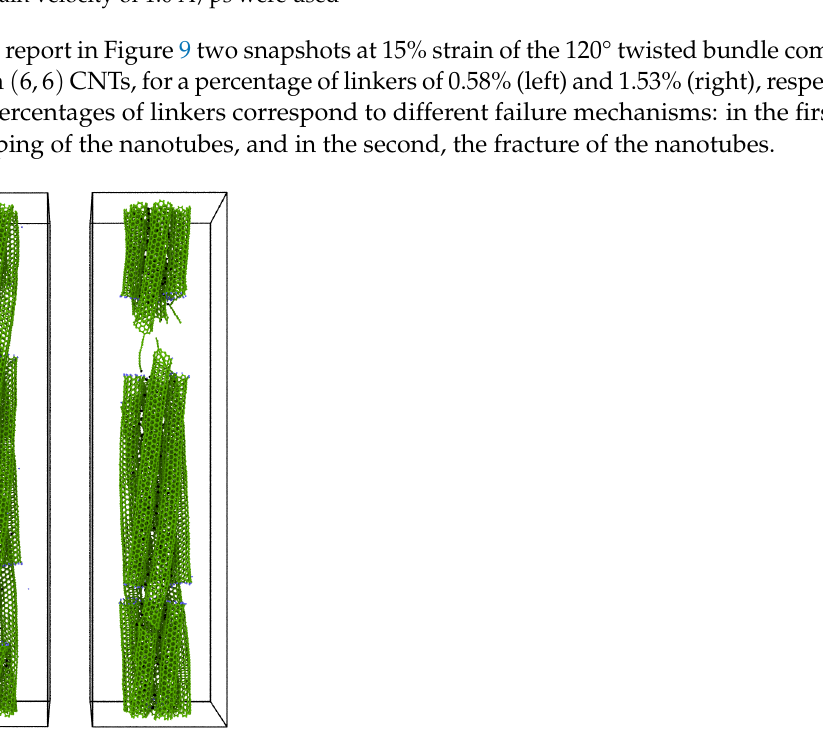
Figure 8. Dependence on twisting and percentage of linkers of Young’s modulus for an infinite bundle composed of ( 6,6 ) CNTs with a periodic supercell of 20 nm in length. AIREBO-mod potential and a strain velocity of 1.0 Å/ps were used